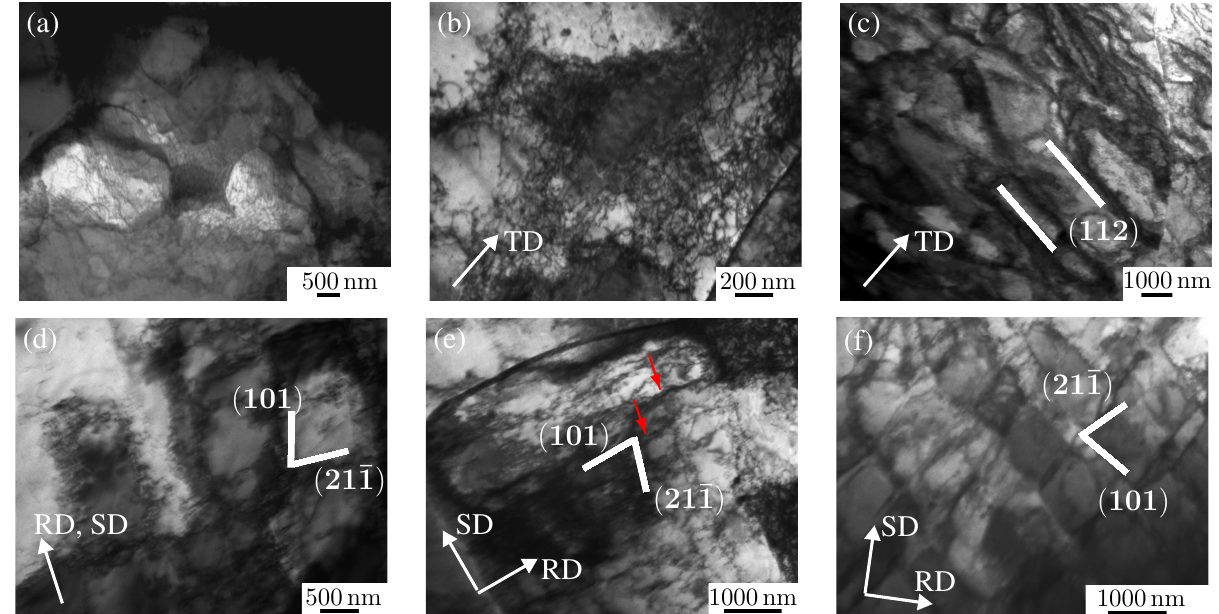
Figure 2. TEM images of dislocation structures of DC06: ( a ) as-received material; after plane strain tension up to 10% ( b ) and up to 20% ( c ) for tension in the rolling direction (RD); after 10% ( d ), 20% ( e ) and 30% ( f ) simple shear loading where shear direction (SD) is orthogonal to the RD. The red arrows in ( e ) indicate a family of dislocation walls parallel to the longitudinal direction of the grain center with a distance of about 50 nm (which